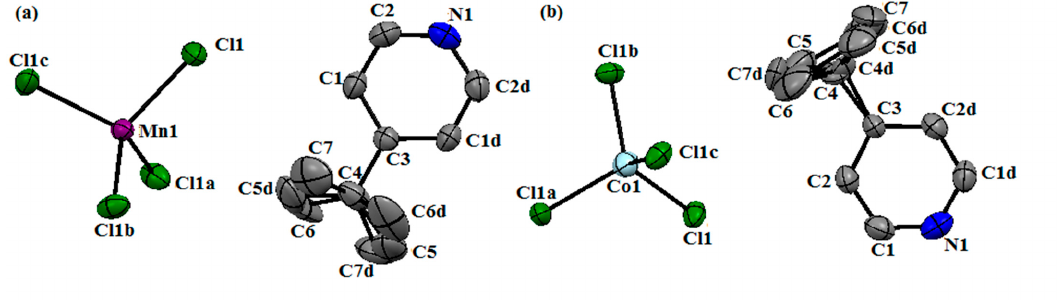
Figure 2. Molecular structures showing 50% probability ellipsoids of [C 9 H 14 N] 2 [MnCl 4 ] ( a ) and [C 9 H 14 N] 2 [CoCl 4 ] ( b ). The hydrogen atoms are removed for clarity in the